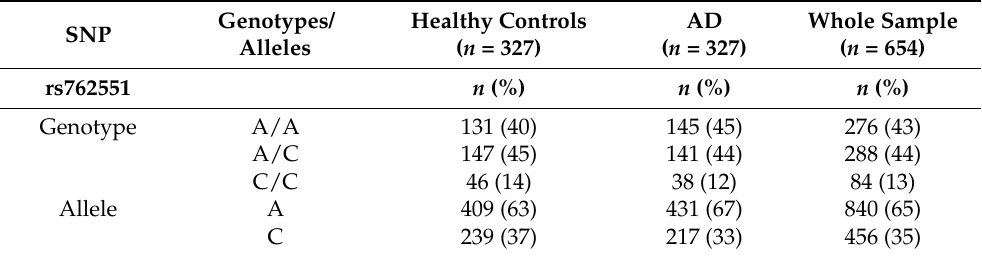
Table 3. Allelic and genotype frequencies for CYP1A2 rs762551 in healthy controls, in AD cases, and in whole sample. Genotypes/ SNP Alleles